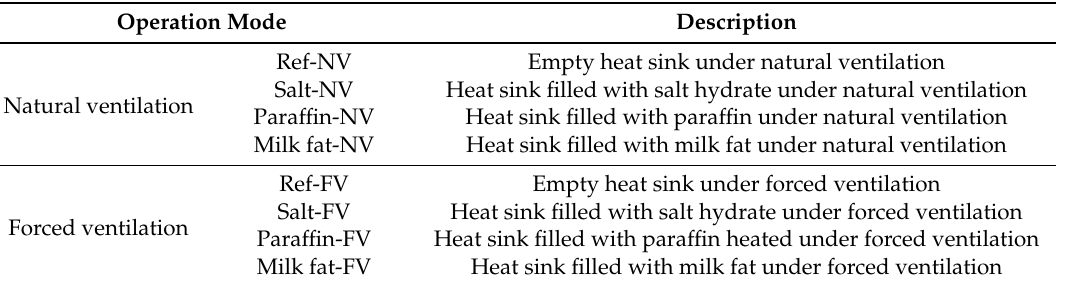
Table 1. Experimental modes of operation.